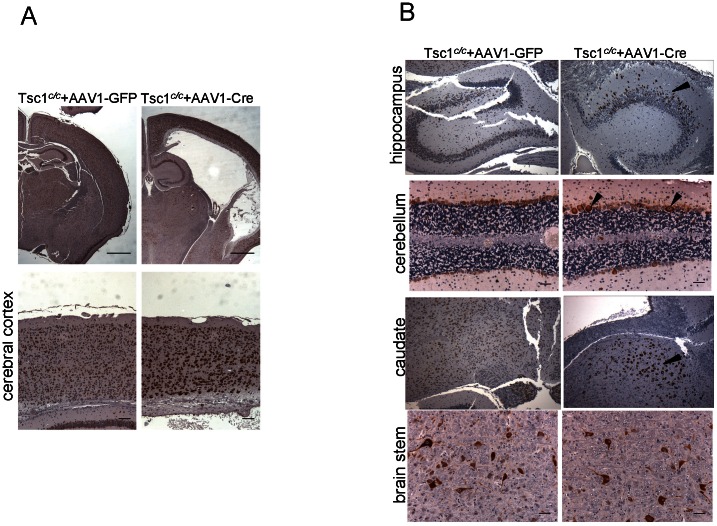
Hydrocephalus and enlarged pS6+ cortical cells in Tsc1c/c mice injected with AAV1-CBA-Cre vector.
Tsc1c/cROSA homozygous pups were injected ICV at P0 with either an AAV1-CBA-GFP (N = 6) or AAV1-CBA-Cre (N = 10) vector at a concentration of 2×1010g.c per ventricle. One month later pups which had received AAV1-CBA-Cre virus developed tremor (N = 8) and were found to have hydrocephalus by pathologic analysis (N = 2). (A) Representative images of brain (upper panels) and cerebral cortex (lower panels) showing in AAV1-CBA-Cre injected animals severe hydrocephalus, large portion of enlarged cortical cells with strong pS6-positivity, and condensed cortical thickness due to swelling of ventricles. Scale bars = 1 mm, upper; 100 µm, lower. (B) Representative pS6 staining in different brain regions. Enlarged pS6+ cells were ectopically present in striatum oriens of hippocampus (arrowhead) due to migration defect of Tsc1-null cells. Some pS6+ Purkinje cells in the cerebellum as well as neurons in the caudate were notably enlarged (arrowheads). Neural cells in deep nuclei such as the brain stem showed similar distribution of pS6 positivity in Cre and GFP injected mice. Scale bars = 50 µm.